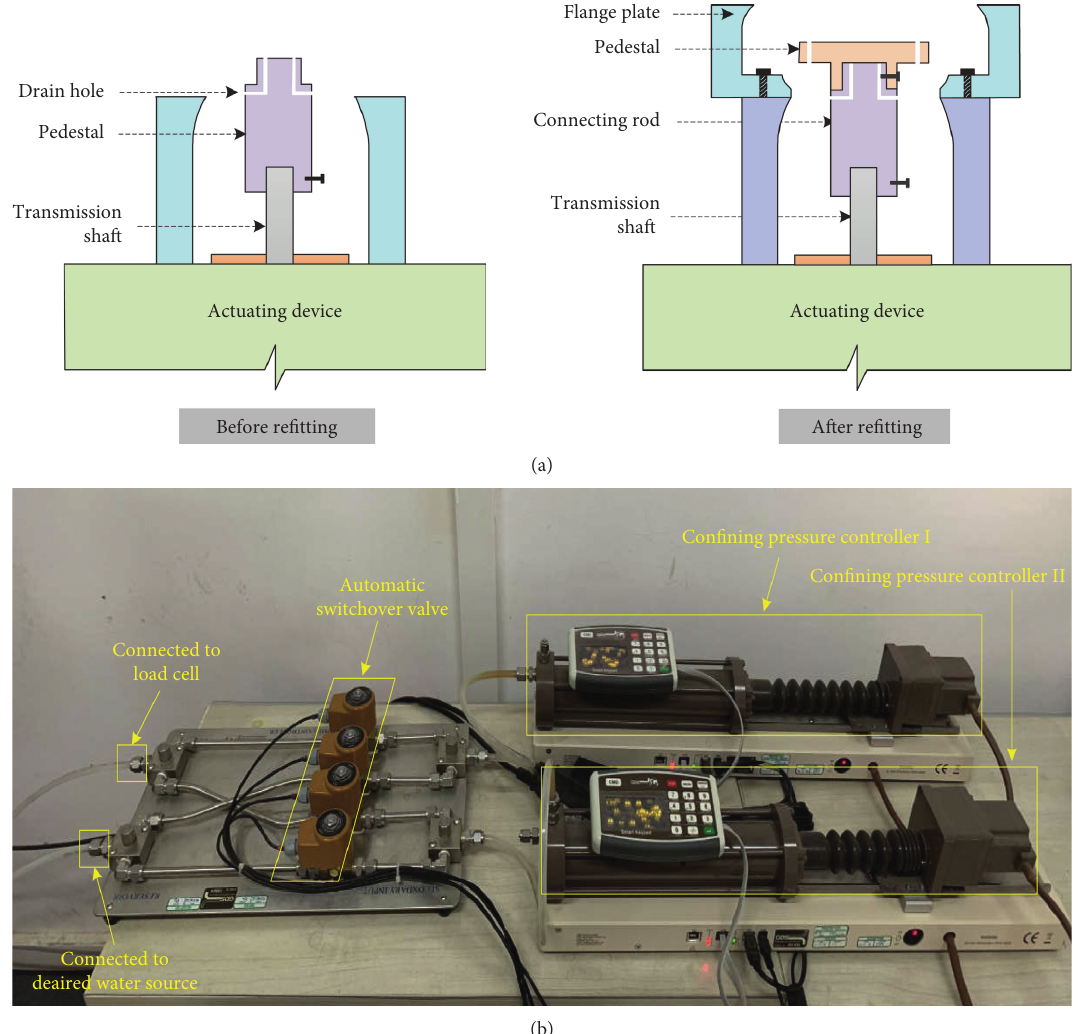
Figure 4: Refitting scheme of GDS triaxial apparatus for (a) pedestal and flange plate to support large load cell and (b) infinite confining pressure switchover device to supply sufficient pressure